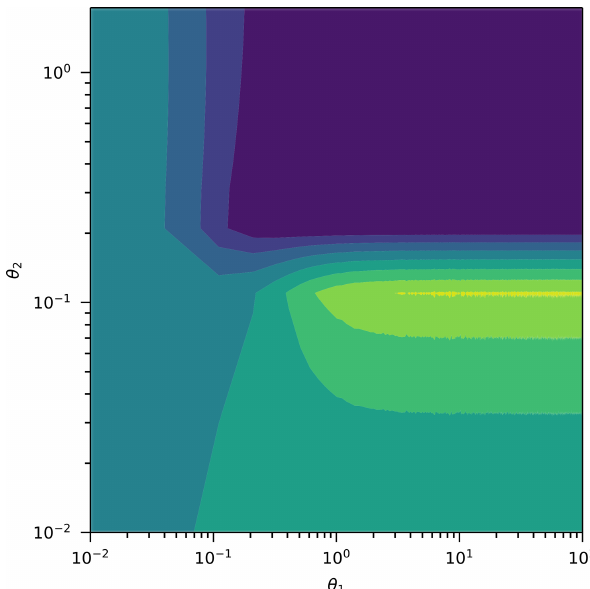
Figure 3. Log-likelihood function for the binary observations as a function of the inadequacy function parameters.